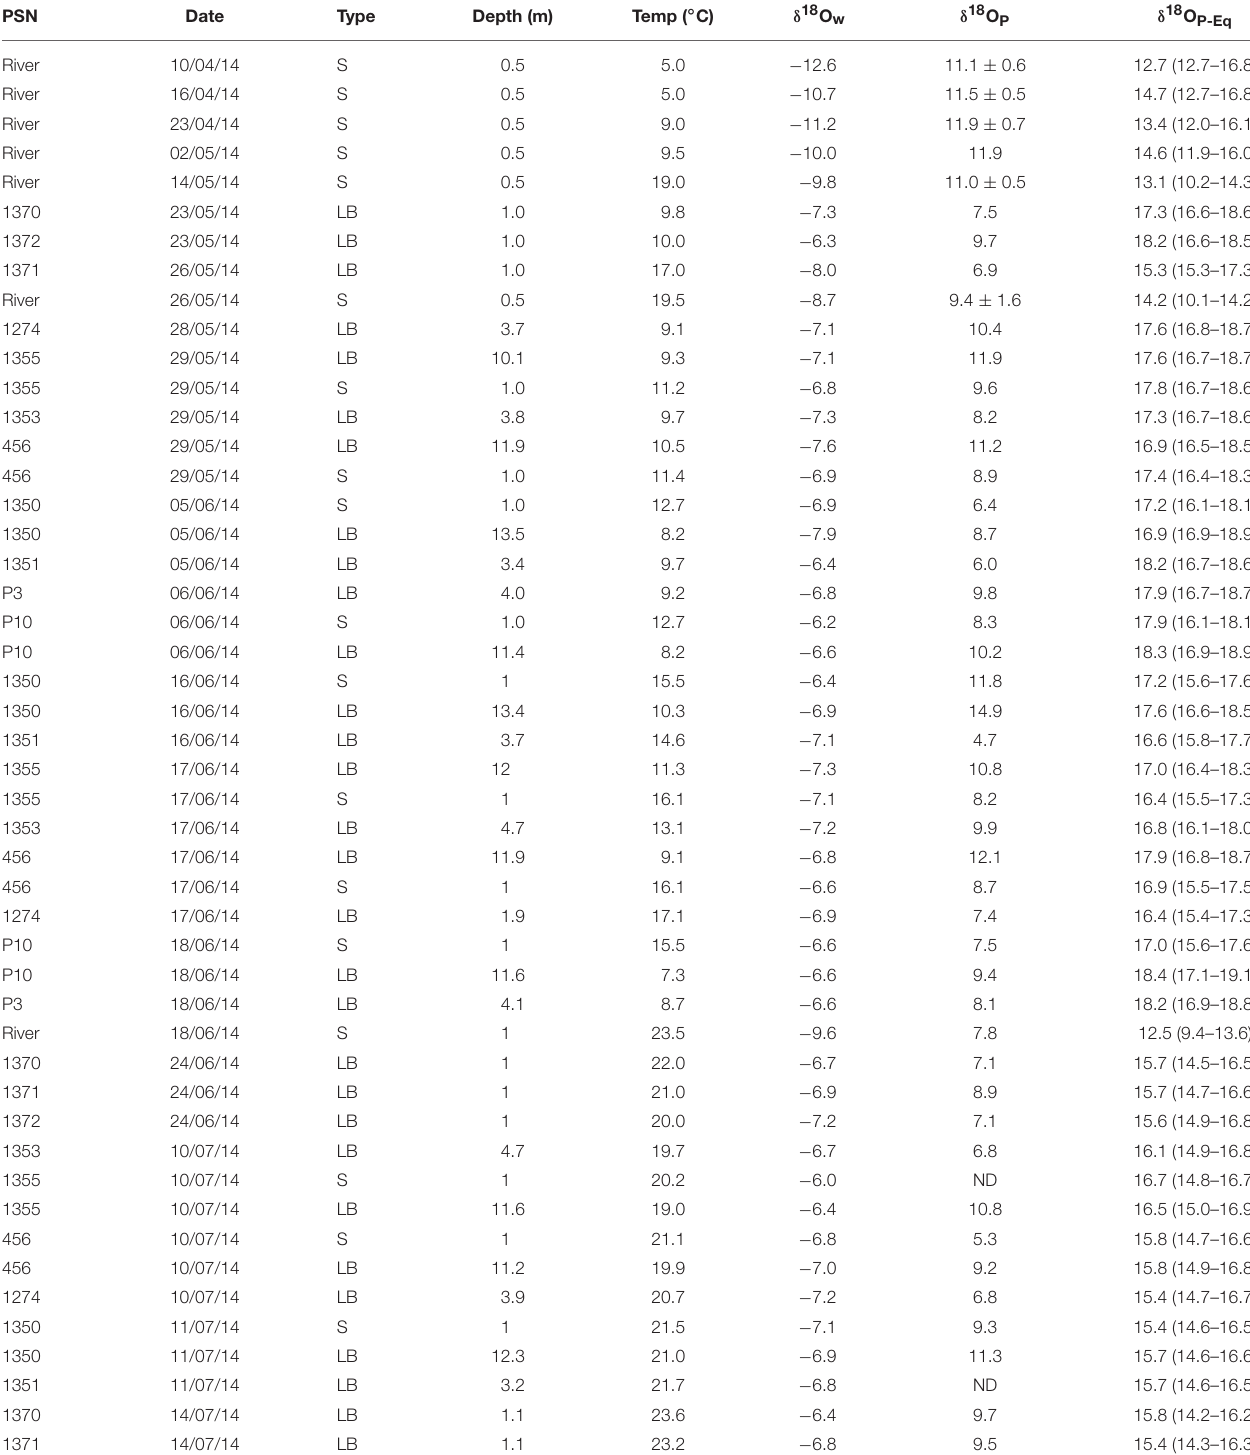
TABLE 1 | Oxygen isotopic compositions of water ( δ 18 O w ), phosphate ( δ 18 O P ), and calculated equilibrium phosphate oxygen isotopic compositions ( δ 18 O P − EQ ) for different sites, dates, and depths in eastern Lake Erie and the lower Grand